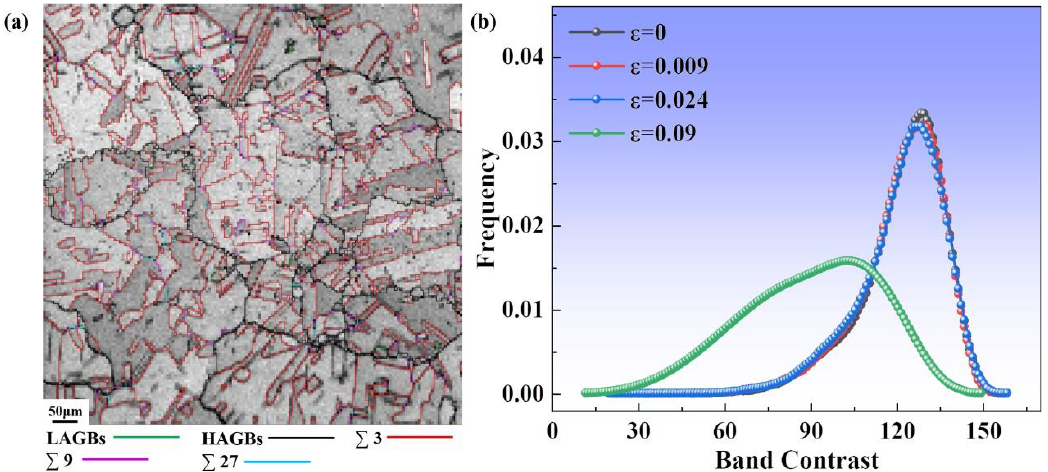
Figure 3. ( a ) The EBSD band contrast (BC) map of the original specimen in the annealed state. ( b ) Distribution of EBSD band contrast (BC) value under different strains.